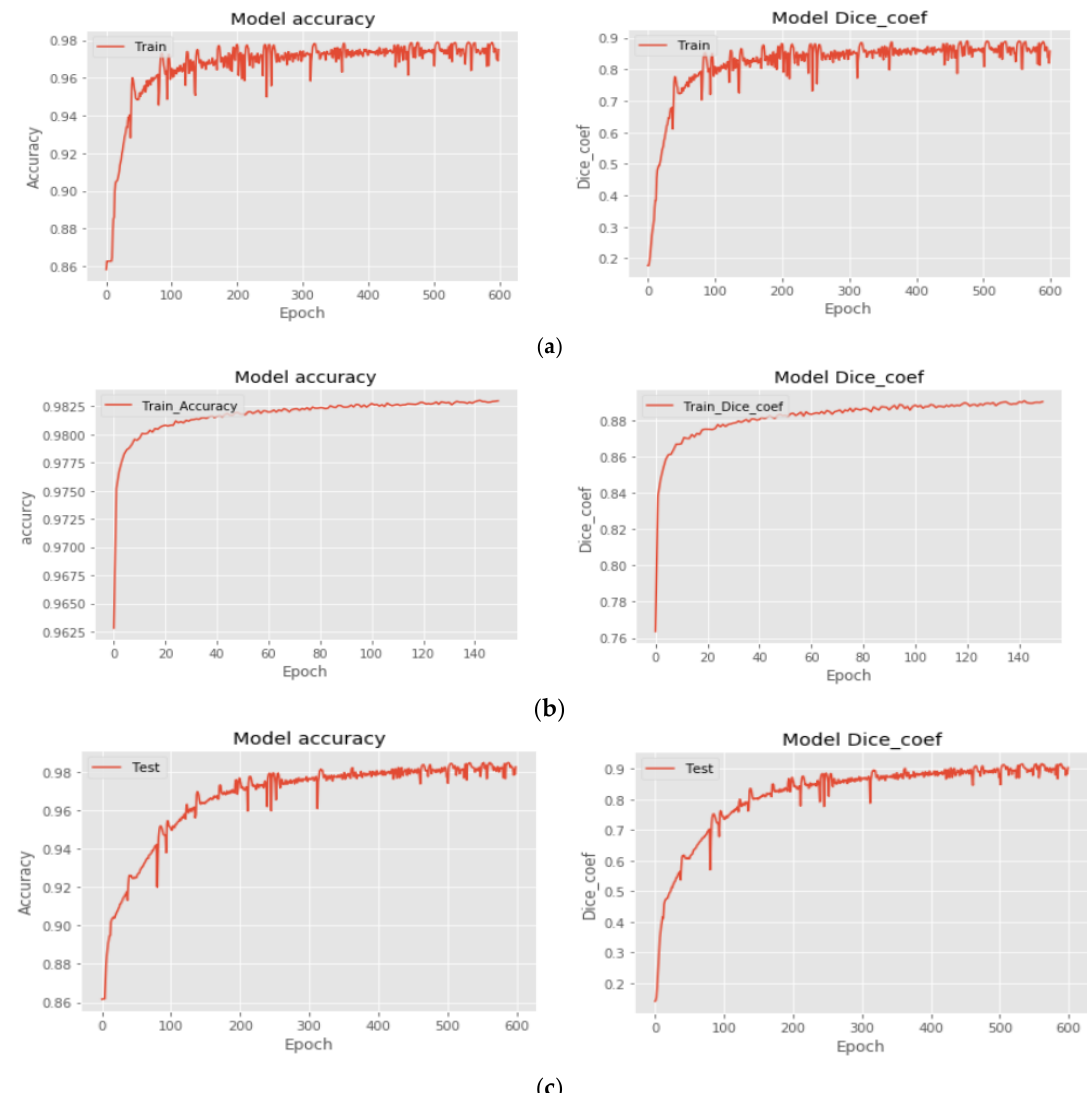
Figure 6. Comparisons of the OAAs and DSCs for ( a ) the Auto-encoder.ResNet, ( b ) the Full Res-Unet, and ( c ) the Res-Unet (Orig. Rse.).